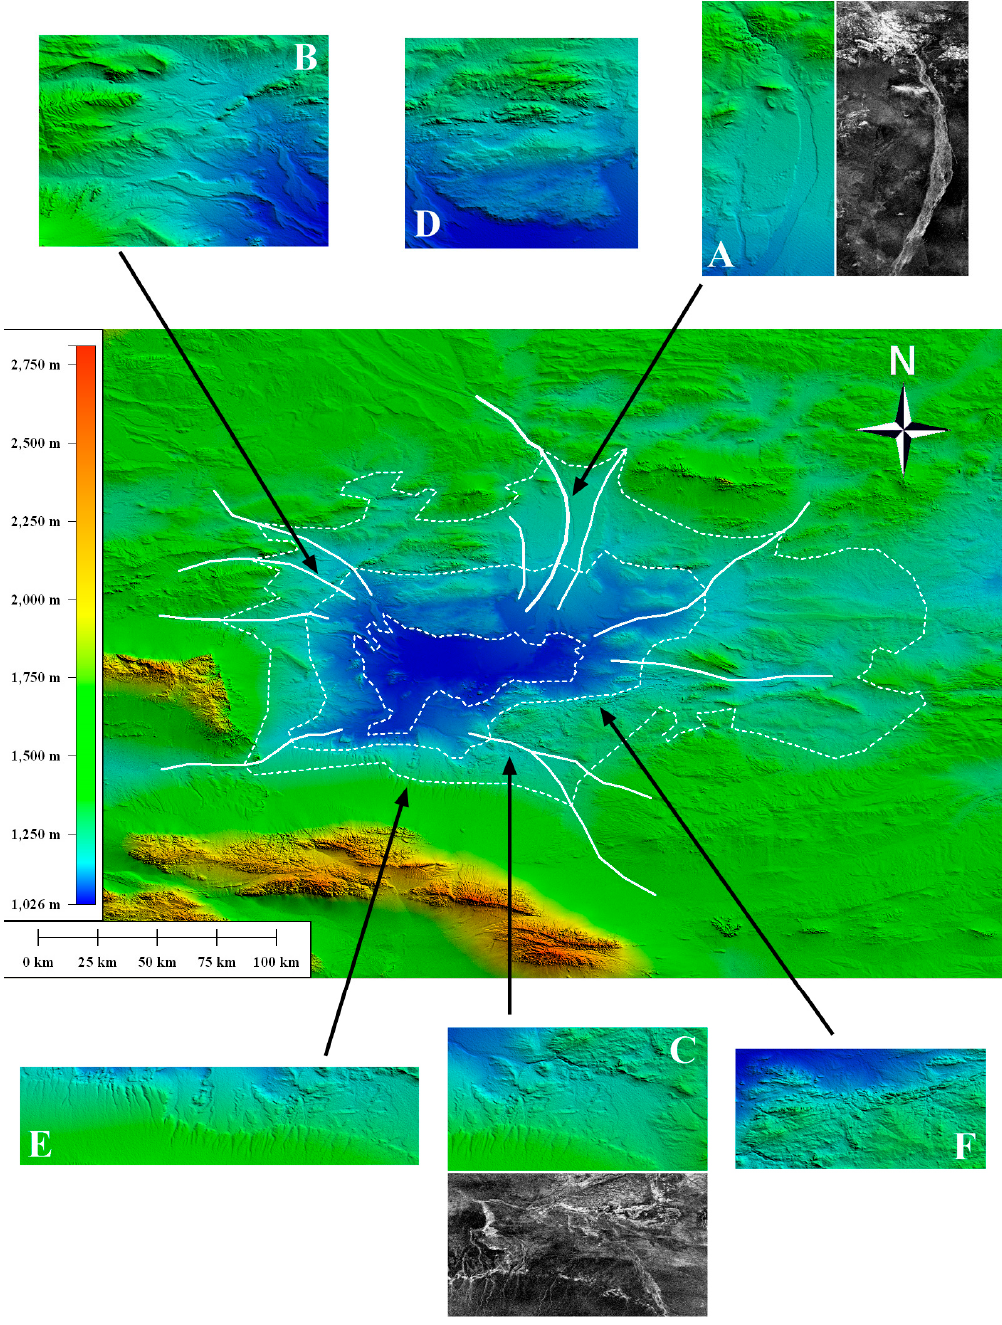
Figure 5. Ulaan Nuur depression on top of SRTM topography, showing the three past lake levels (dotted white lines) and the ten palaeochannels (solid white lines). Ulaan Nuur’s main streams are the Ongi River ( A ) and a southeastern channel ( C ). Terminal fans of secondary tributaries ( B ) and palaeoshoreline morphologies ( D – F ) remain visible in the present day topography.